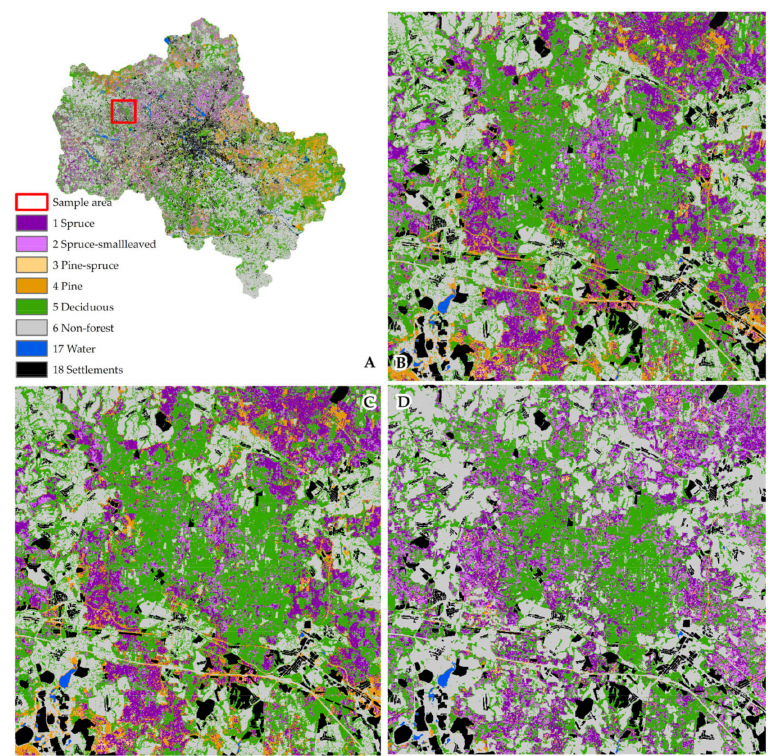
Figure 9. Typological diversity of forests in the model area at different time intervals. ( A )—Location of the model area within the study territory, structure of formations: ( B )—1990; ( C )—2010; ( D )—2020.